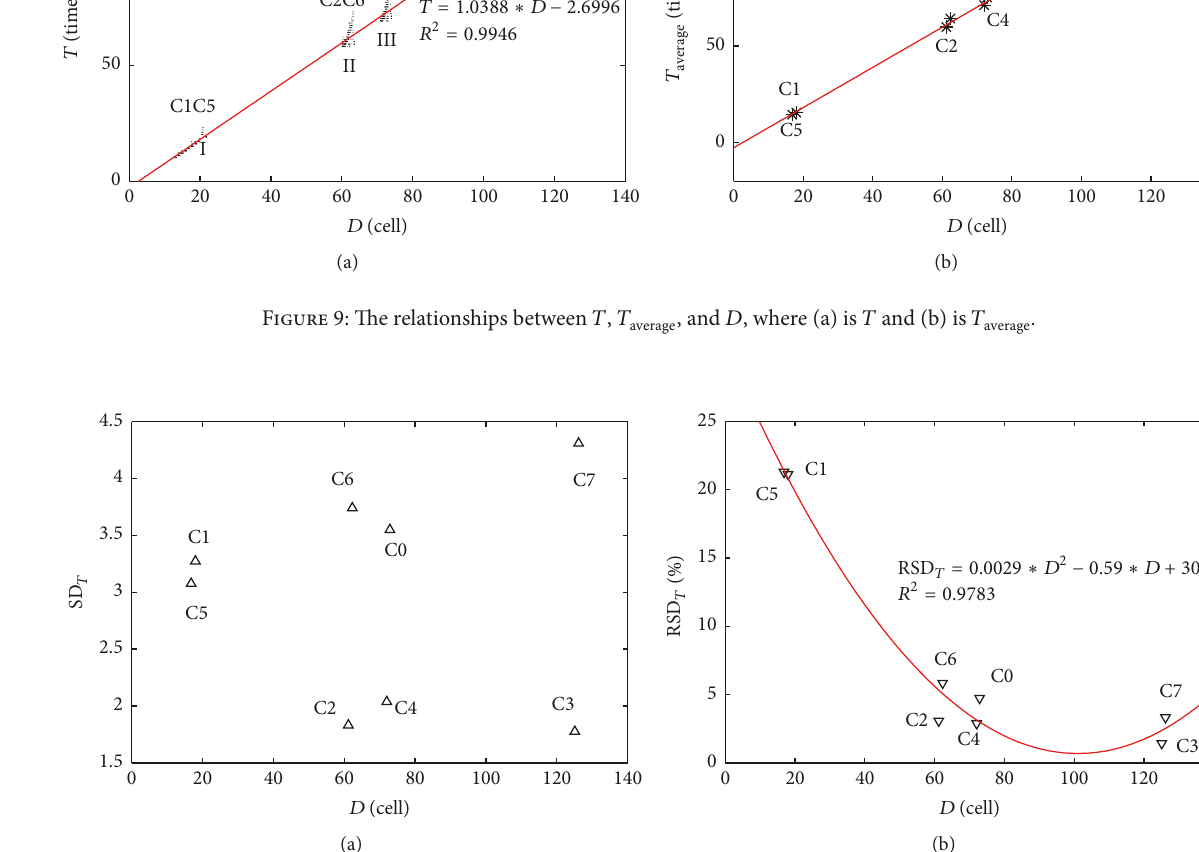
Figure 10: The relationship between SD 𝑇 , RSD 𝑇 , and 𝐷 , where (a) is SD 𝑇 and (b) is RSD 𝑇